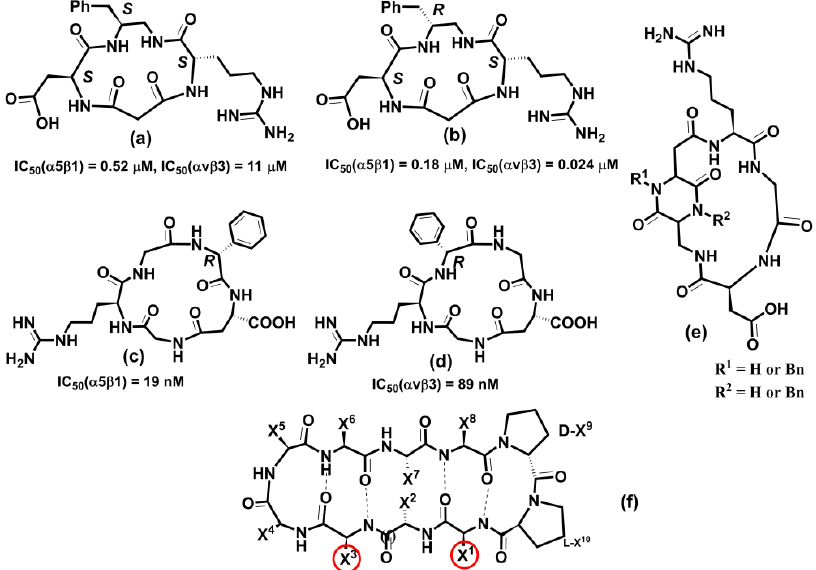
Figure 13. Schematic representation of RGD antagonists: ( a ) c[( R )- β -Phe- ψ (NHCO)Asp- ψ (NHCO)Gly-Arg]; ( b ) c[( S )- β -Phe- ψ -(NHCO)Asp- ψ (NHCO)Gly-Arg] [343]; ( c ) c[phg iso DGRG]; ( d ) c[G iso DGRphg] [344], where phg = D-phenylglycine; ( e ) trans-cyclo [DKP-RGD] [345]; and ( f ) 10-mer cyclic peptide [346],